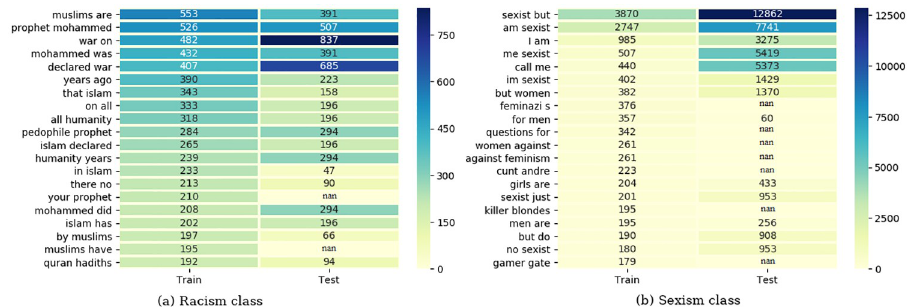
Fig 4. The top 20 LMI-ranked n -grams ( n = 2) that are highly correlated with the negative classes of Waseem- dataset (Racism and Sexism) in the training and test sets. nan value denotes computationally infeasible, as the occurrence is zero in the test set.